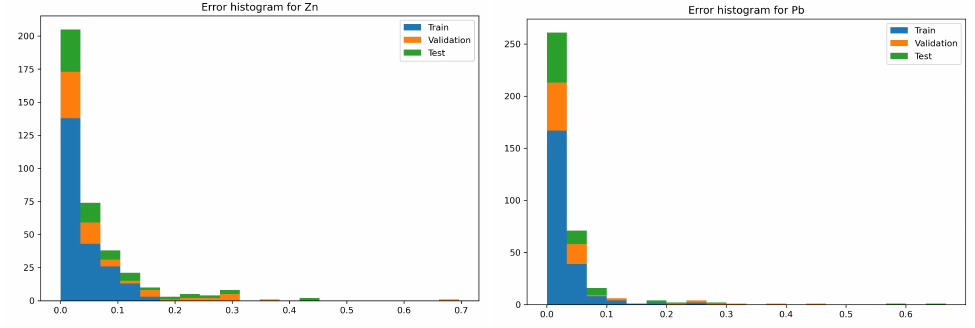
Figure 7. Histogram of mean absolute errors calculated for training, test and validation data sets for structure number 10. ( Left ) panel shows results for zinc and ( right ) panel for lead.